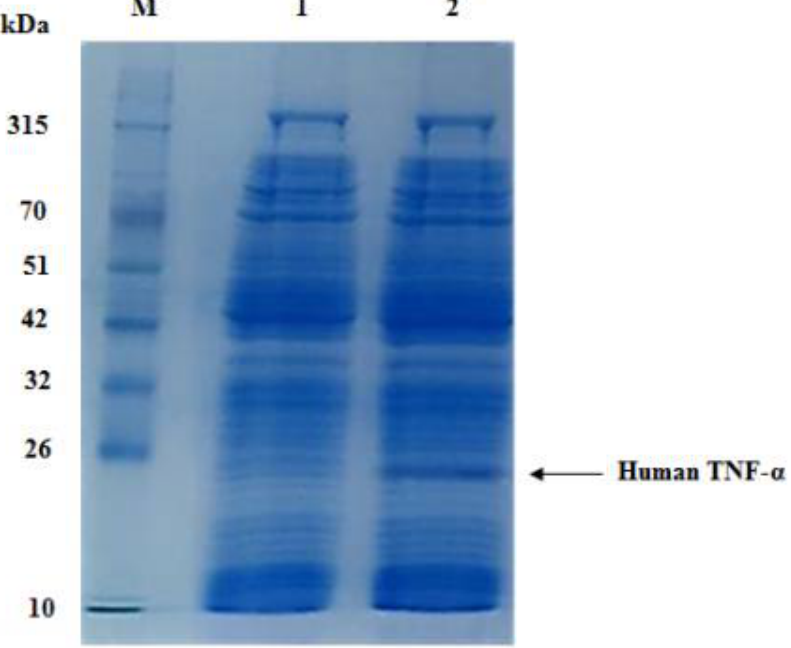
Figure 7. SDS-PAGE analysis of cell-free synthesized human TNF-α protein at 30 °C within 6 h. Lane M: a prestained protein marker (10–315 kDa), lane 1: negative control reaction and lane 2: cell-free synthesized human TNF-α protein (21 kDa).